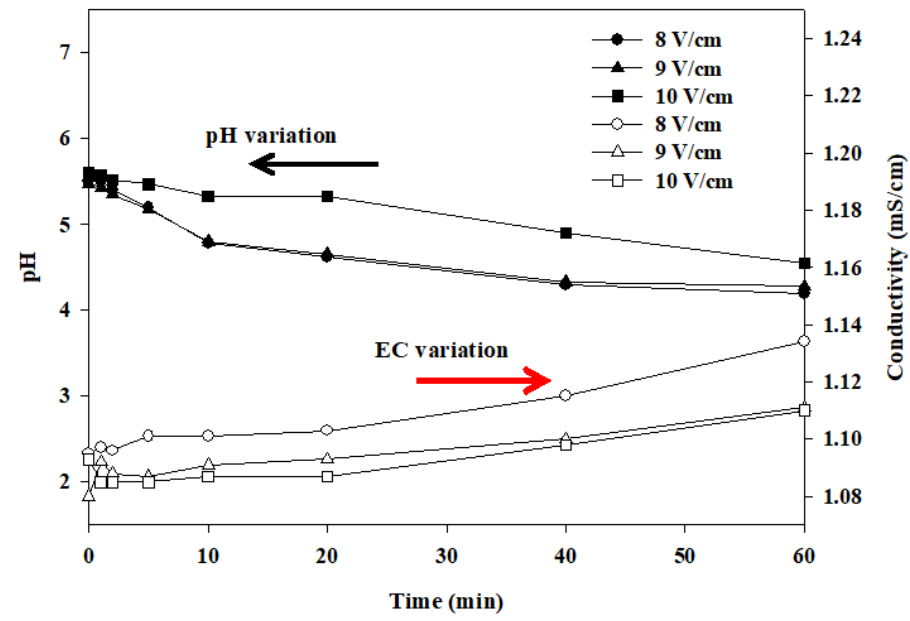
Figure 4. The tread of pH and conductivity with different voltage gradients.